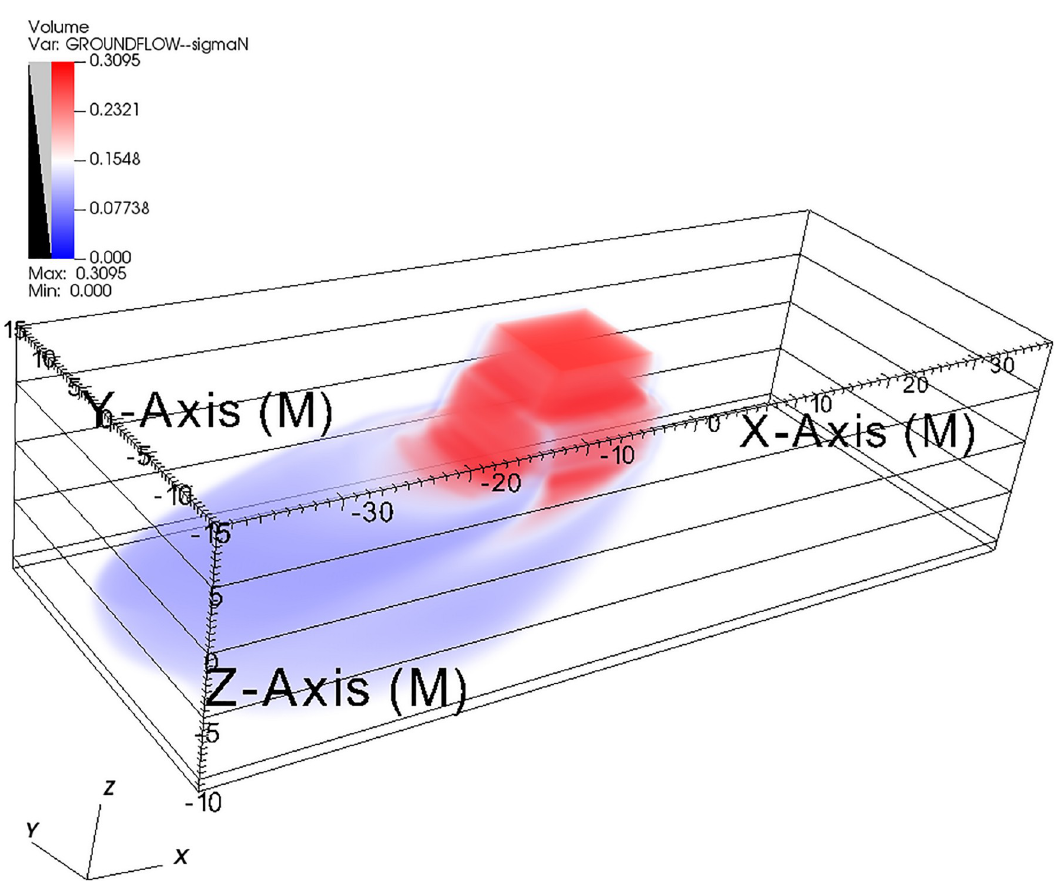
Fig 16. Saturation iso-surface of DNAPL (with an impermeable lens) at time 8.15 days. The three-dimensional visualization of the numerical simulation results of the contaminant saturation iso-surface at time 8.15 days. Notice the impermeable parallelepiped zone just below the contaminant released on top of the grid. This figure was generated using VisIt (an open-source post-processing) and the three-dimensional saturation data of Fig 14.